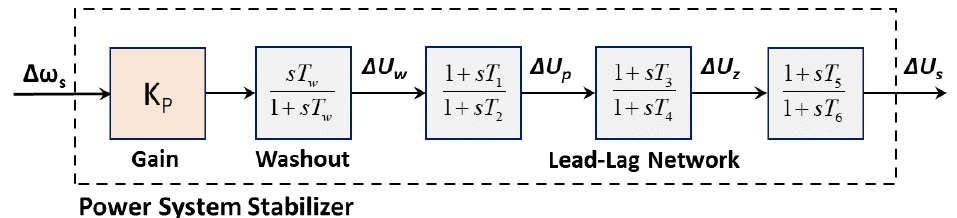
Figure 3. Block diagram of a classical power system stabilization.